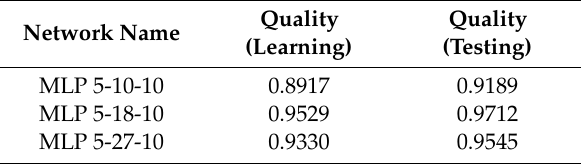
Table 5. Selected ANNs quality assessment.